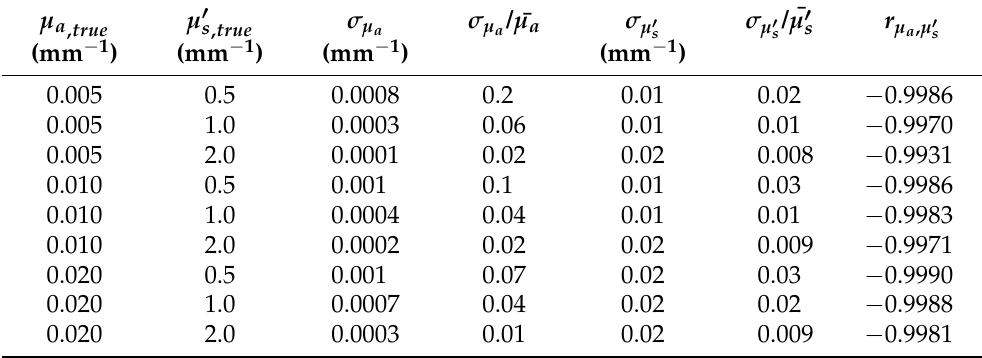
Symbols: Absorption coefficient ( µ a ), reduced scattering coefficient ( µ (cid:48) s ), Green’s function for the